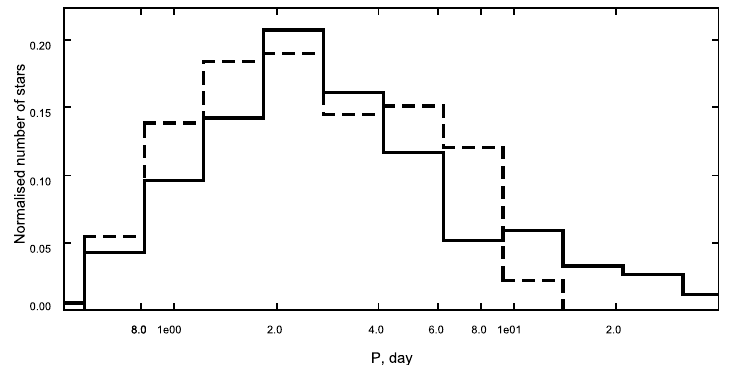
Fig. 6. Catalogued (solid line) and simulated (dashed line) Algols: the orbital period